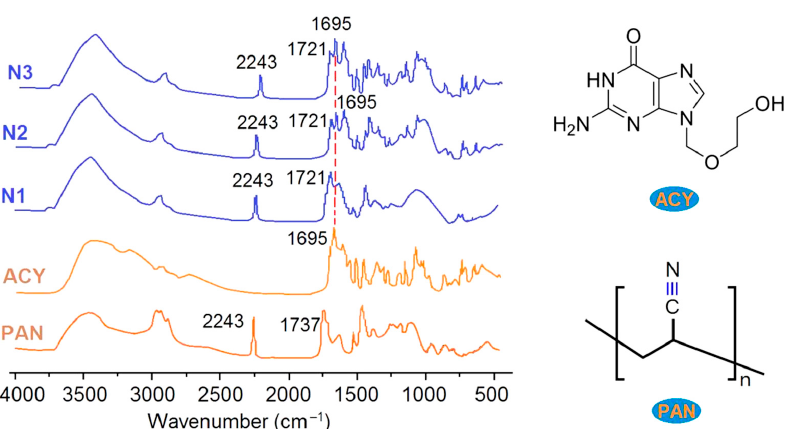
Figure 7. The FTIR spectra of the drug, ACY; polymer, PAN; their composites of N1; and their na- nohybrids of N2 and N3, as well as the molecular formula of ACY and PAN.